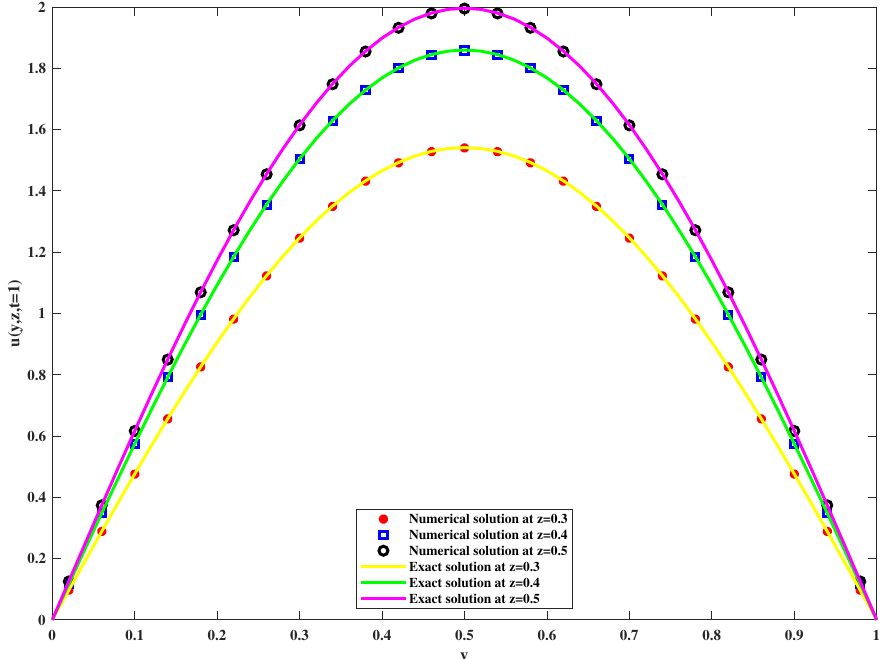
Figure 11. Comparison of exact solution and numerical solution in special case